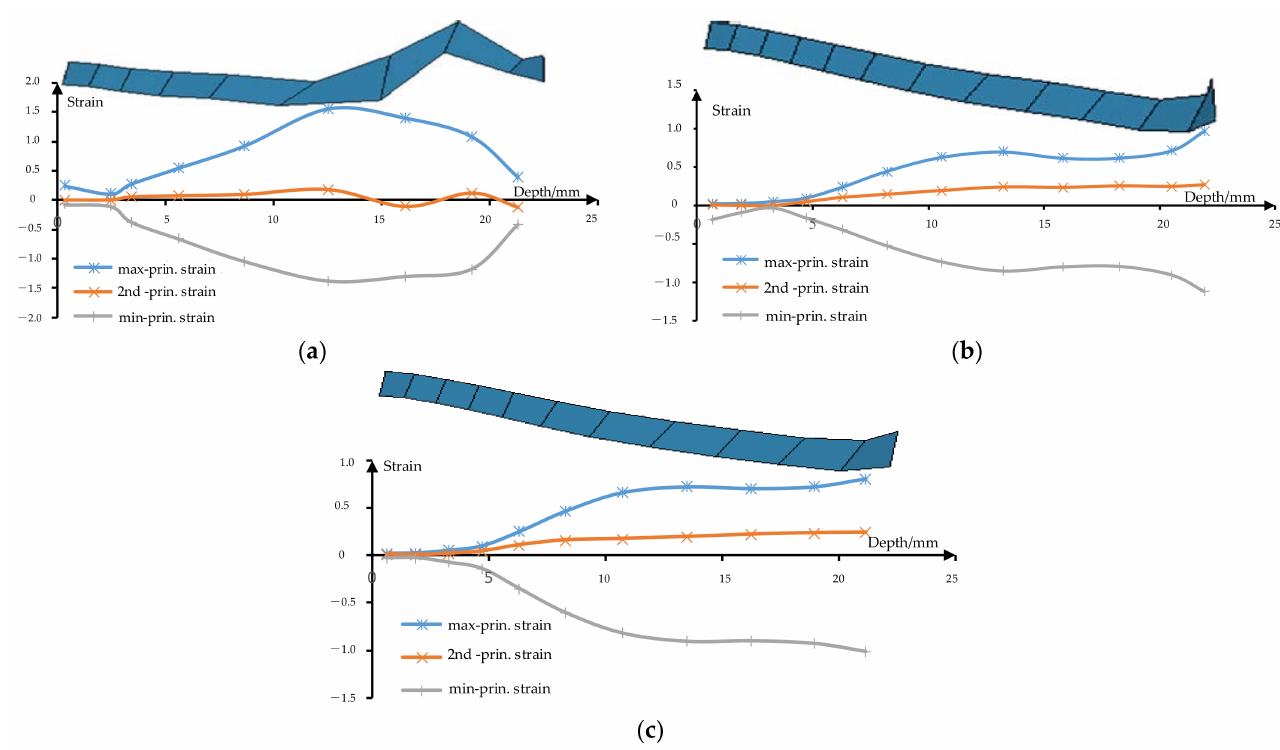
Figure 14. The strain curves: ( a ) the traditional multi-stage; ( b ) the proposed method ( ψ = 5 ◦ ); and ( c ) the proposed method ( ψ = 15 ◦